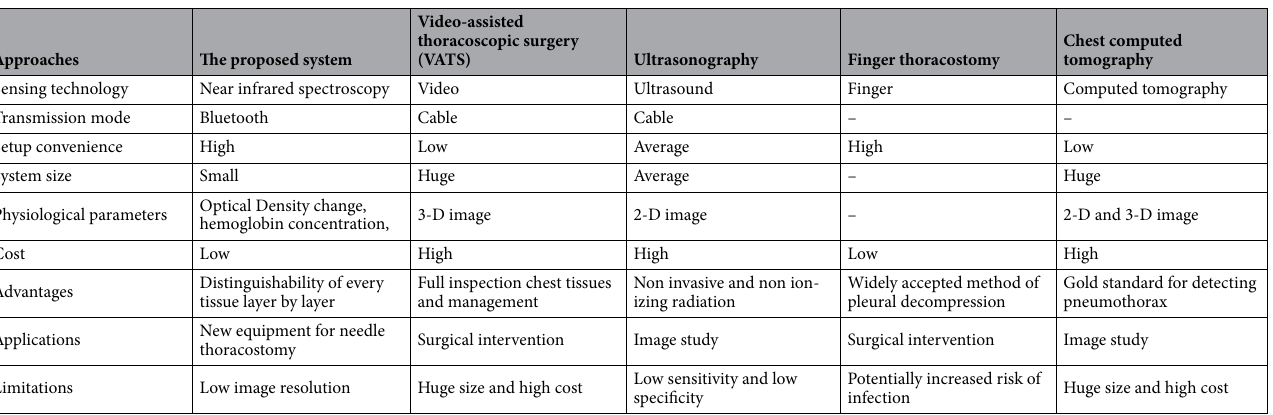
Table 1. Comparison between the proposed system and other